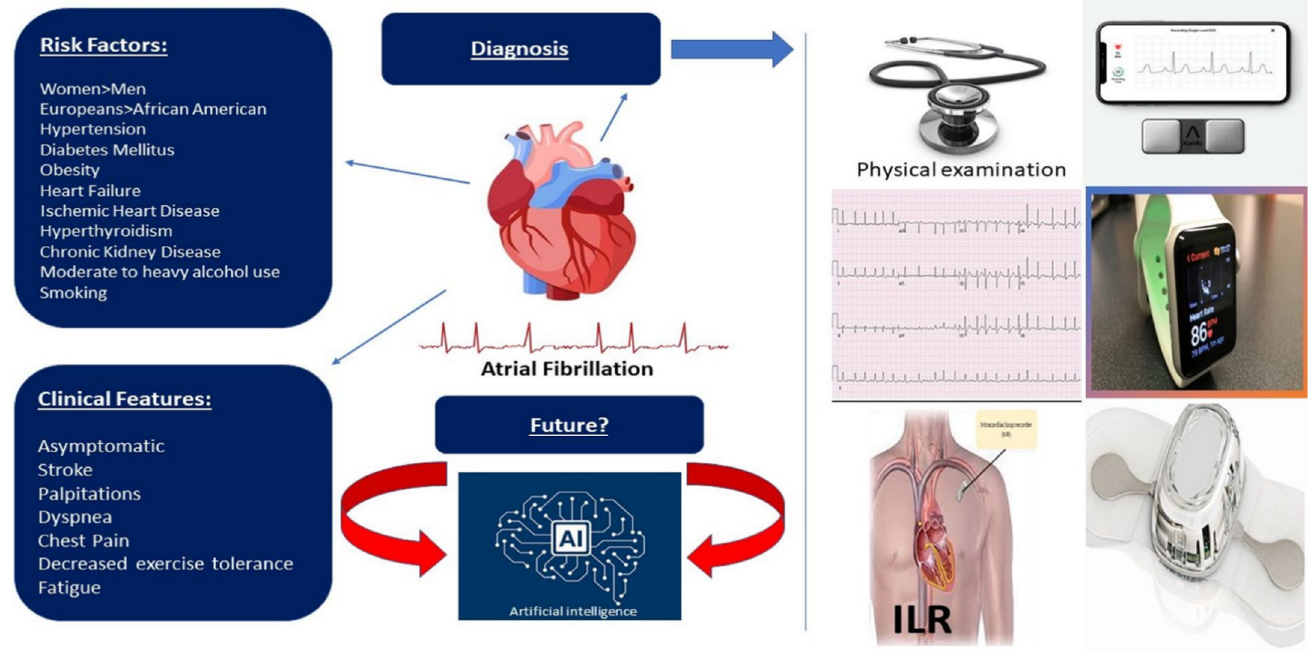
Figure 1. Wearable devices incorporated into diagnostic plan to help pick up silent and paroxysmal atrial fibrillation. Development of artificial intelligence and machine learning will play a major role in the process of